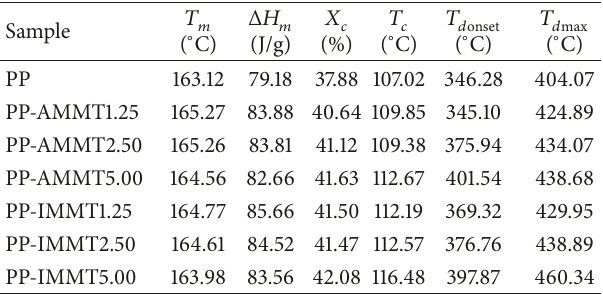
Table 1: DSC and TGA characteristics of PP and its nanocompos-